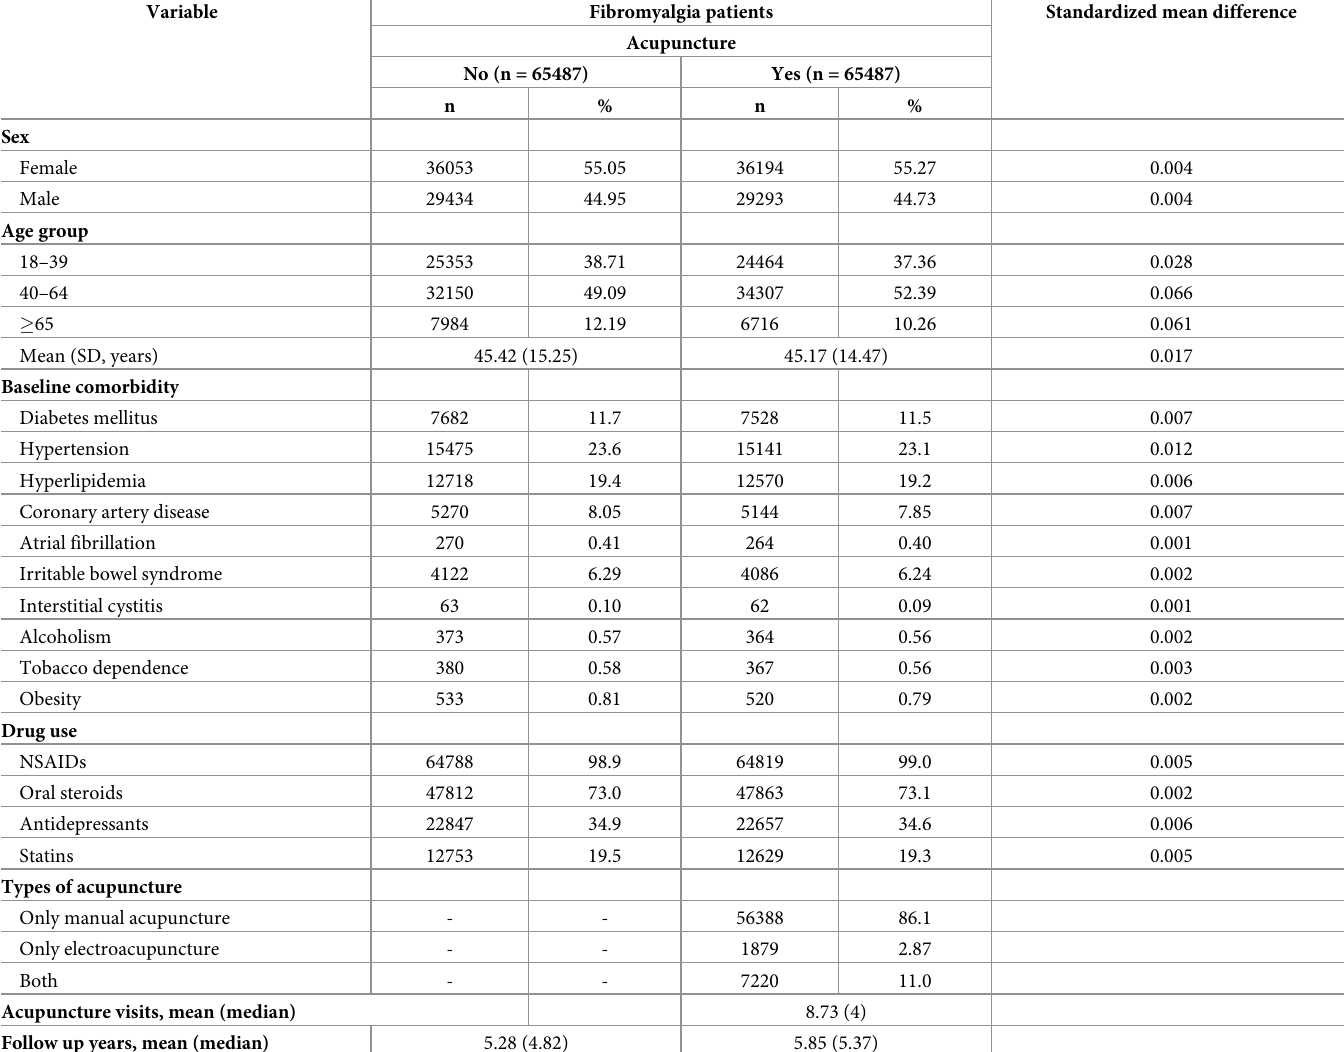
Table 1. Characteristics of fibromyalgia patients according to whether they received acupuncture or not.